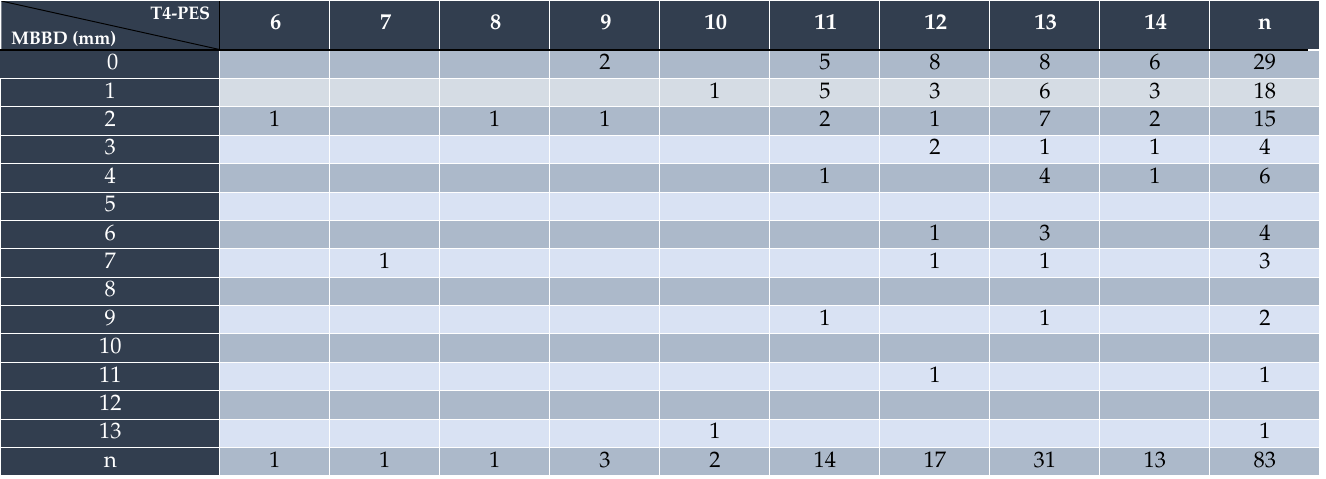
Table 2. Size of post-extraction mid-buccal bone defects (MBBDs) measured in mm related to their 3-year soft-tissue esthetic outcome (T4-PES).